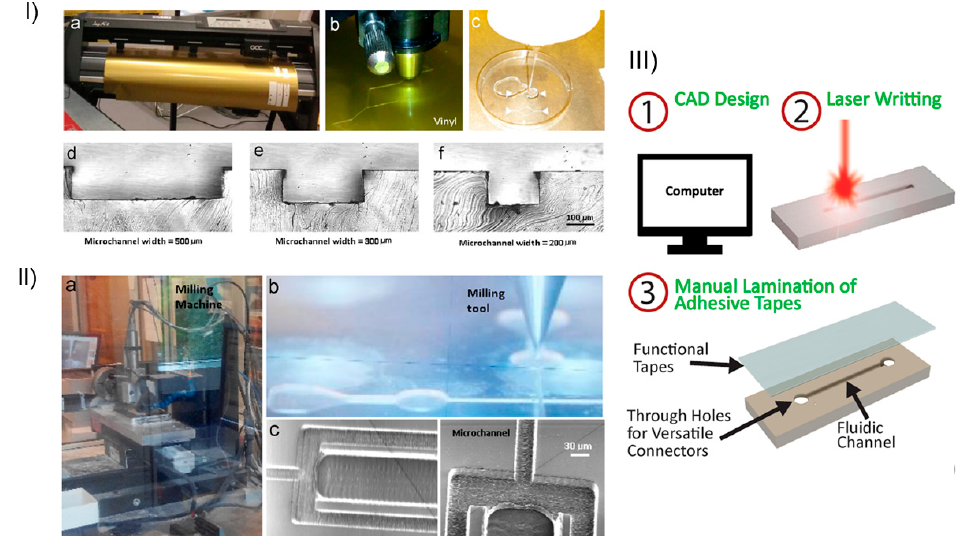
Figure 3. Low-cost print-and-peel microfabrication techniques. ( I ) Xurography: ( a ) cutting plotter machine; ( b ) features being cut by the cutting plotter; ( c ) PDMS being added to a petri dish containing the vinyl mask; ( d ), ( e ) and ( f ) Cross sections of microchannels with 500, 300 and 200 m of width, respectively. ( II ) Micromilling; ( a ) milling machine; ( b ) operating milling tool and ( c ) microchannels. Reproduced with permission from [22]. ( III ) Direct laser plotting main steps. Reproduced with permission from [27].